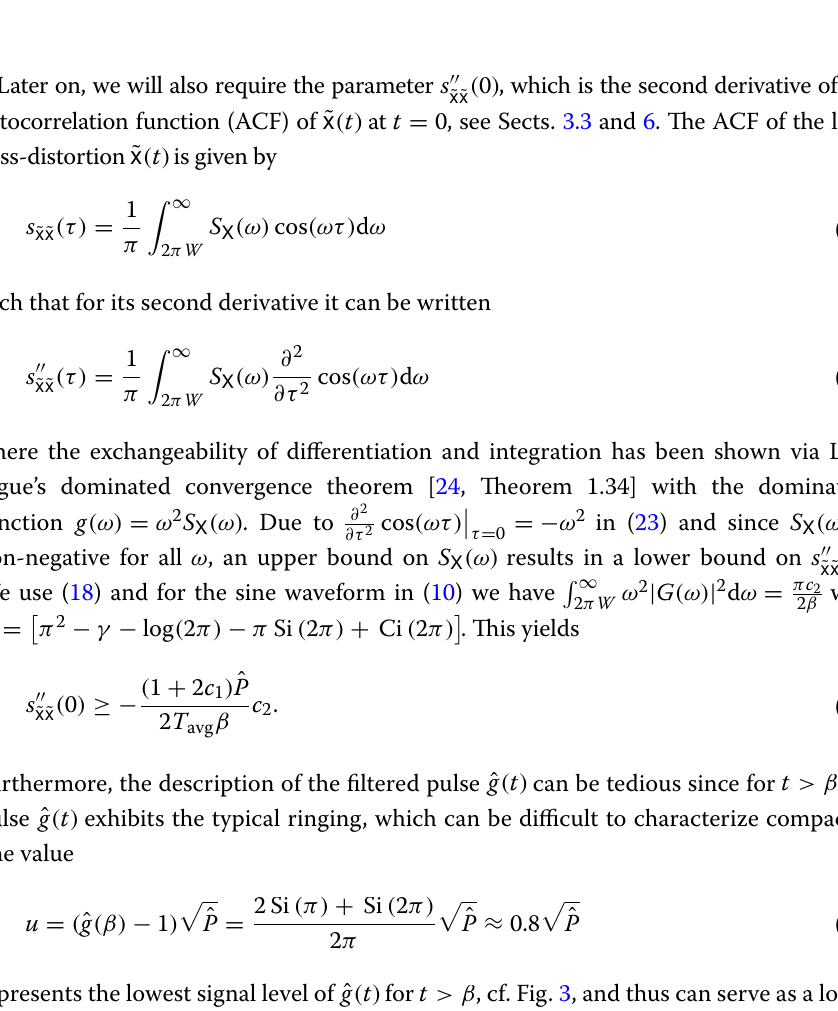
Fig. 3 ISI model: original g ( t at a time t k is the superposition of the contribution of all